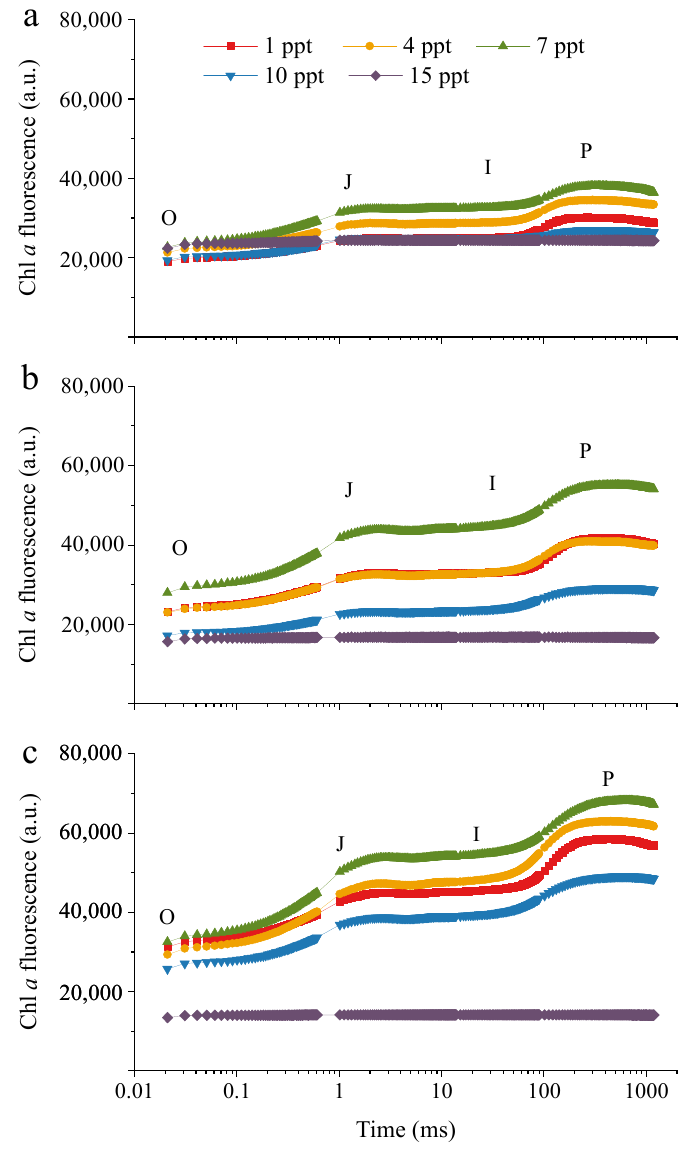
Figure 3. The OJIP curves of M . aeruginosa under different salinity stress on days 3 ( a ), 6 ( b ) and 9 ( c ). Changes in the chl a fluorescence parameters of M . aeruginosa recorded every 3 days are shown in Table 1. A relatively high salinity of 15 ppt seriously damaged the PSII reaction center of M . aeruginosa , resulting in irregular, abnormal values of the chl a fluorescence parameters compared to the control (ANOVA, p < 0.05) and other treatments. Under the 1, 4, 7 and 10 ppt salinity, the V J and M 0 decreased gradually as the experiment progressed, except that the V J at 7 and 10 ppt presented higher values on day 9 than those on day 6. In contrast, the parameters ϕ Po and ϕ Eo increased gradually over time, and both presented the minimum and maximum values on days 3 and 9, respectively, at 10 ppt treatments. Additionally, other than the 10 ppt salinity, the parameter ψ 0 increased gradually with the prolongation of incubation, while it declined as salinity increased at the same time point. The ABS/RC, TR 0 /RC, ET 0 /RC and DI 0 /RC in the 1, 4, 7 and 10 ppt salinity groups showed declining tendencies with fluctuation over time and as the salinity gradient increased. The indicators at 15 ppt showed no obvious trend and included outliers. Indeed, measurements could not be taken in the middle and late stages of the experiment.